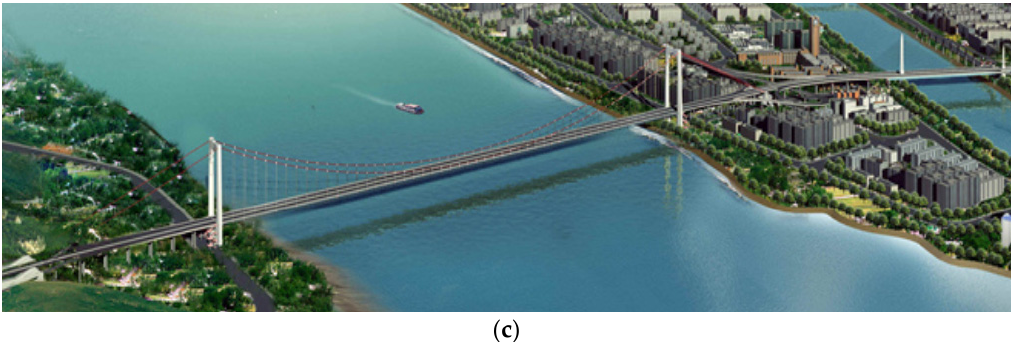
Figure 1. Three test structures in the Structural Health Monitoring of Long-span Bridges (GeoSHM) Demon Project: ( a ) the Forth Road Bridge (FRB) in Scotland, UK (Image from Wikicommons. Author: Klaus with K.); ( b ) the Erqi Bridge in Wuhan, China; and, ( c ) the Zhixi Bridge in Yichang, China.